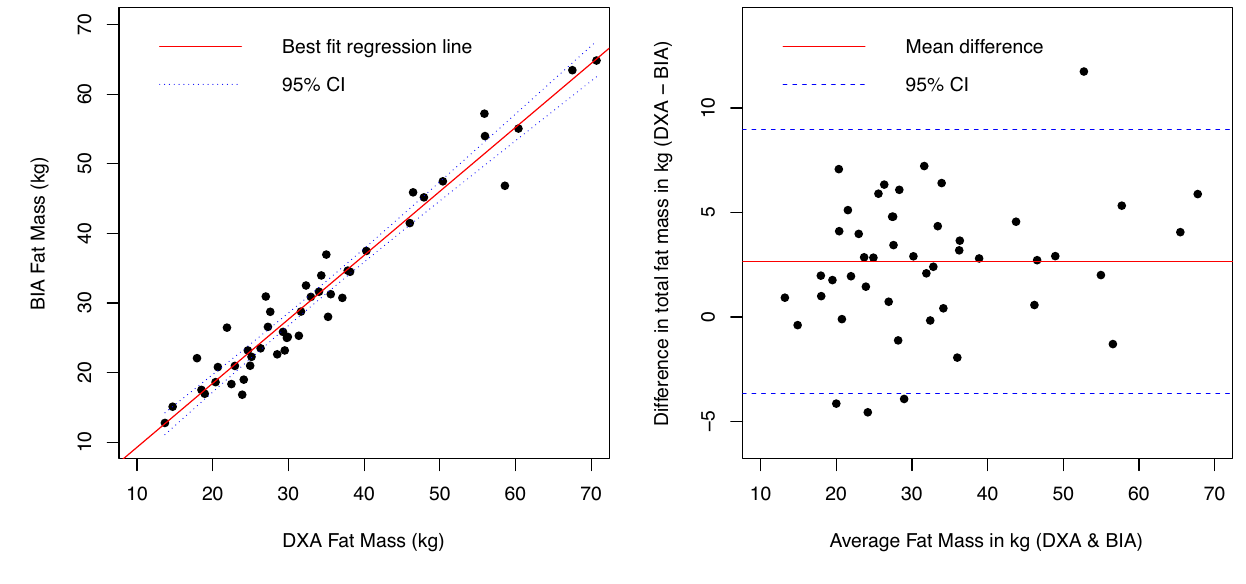
Figure 2. Comparison between bioimpedance (BIA)-derived and dual X-ray absorptiometry (DXA)-assessed fat mass (in kilograms, kg). The left panel is a scatter plot of BIA-derived and DXA-assessed fat mass is shown with the best fit regression (solid red line) and 95% confidence intervals (blue dashed); Spearman ρ = 0.94 (p < 0.0001). The Bland Altman plot is shown in the right panel; average difference between BIA-derived and DXA-assessed fat mass was 2.7 ± 3.2 kg (solid red line); 95% confidence intervals are shown as blue dashed lines.